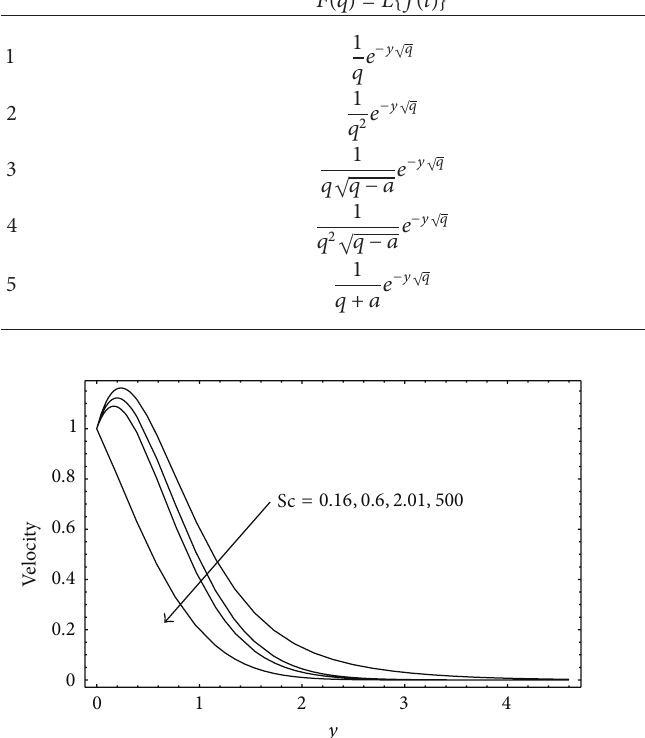
Figure 10: Velocity profiles for different values of Sc when 𝑡 = 0.3, 𝑅 = 0.5, Pr = 0.71, Gr = 3, Gm = 2, 𝛾 = 1 , and 𝜔 = 0 .